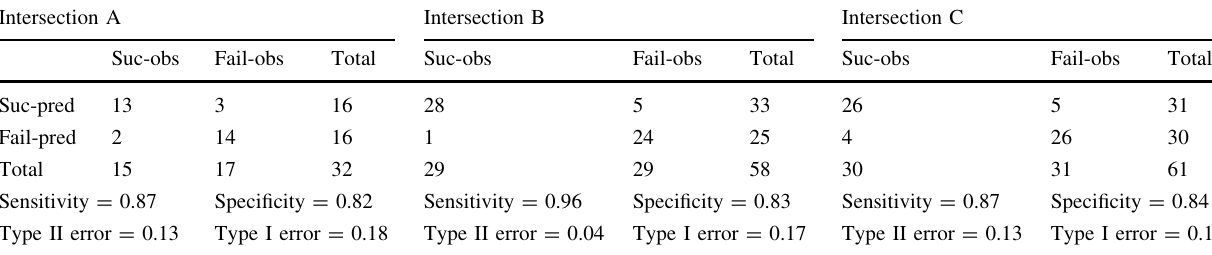
Table 7 Prediction success table (without considering aggressive behavior)